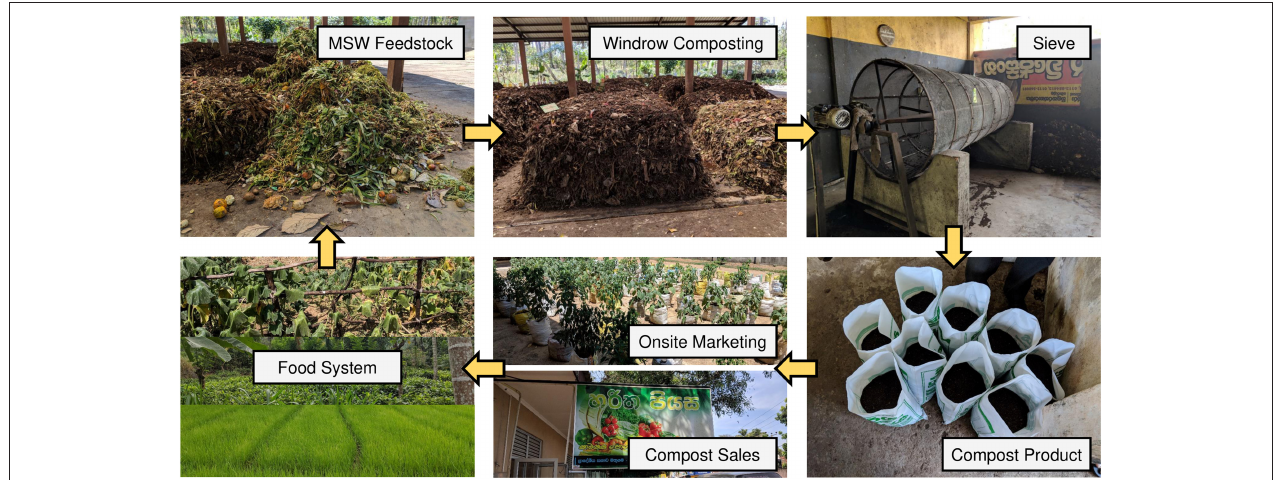
FIGURE 3 | Municipal solid waste (MSW) composting systems in Sri Lanka, illustrating the composting process, marketing/sales, and food system components. All photos by E. Roy.